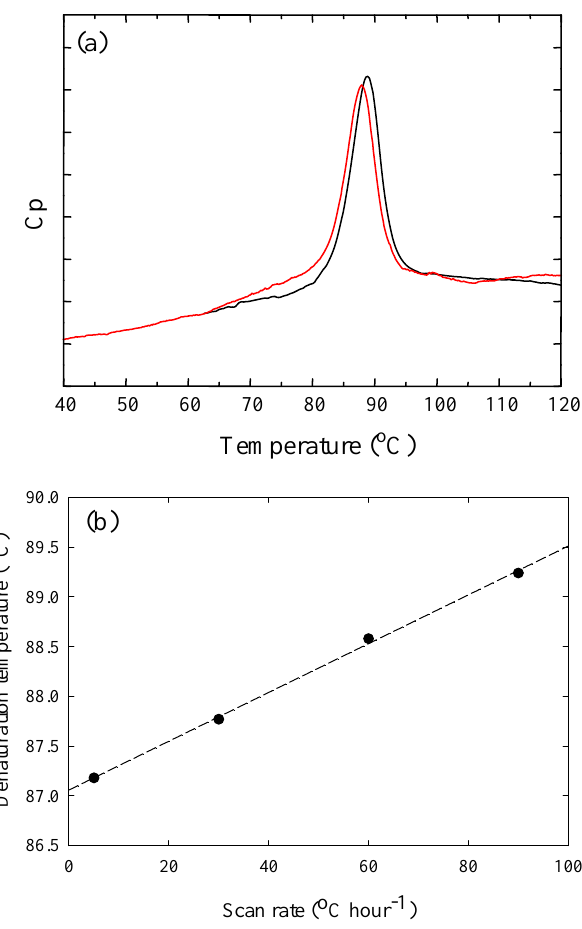
Figure 5. (a) Dependence of DSC curves of Tk-RNase HII on the scan rate. Samples with the same protein concentration were measured at different scan rates. Red and black lines represent the DSC curves at scan rates of 30 and 60 °C hour -1 . (b) Dependence of the denaturation temperature on scan rate. The dashed line represents a linear fit. Figures are reproduced from